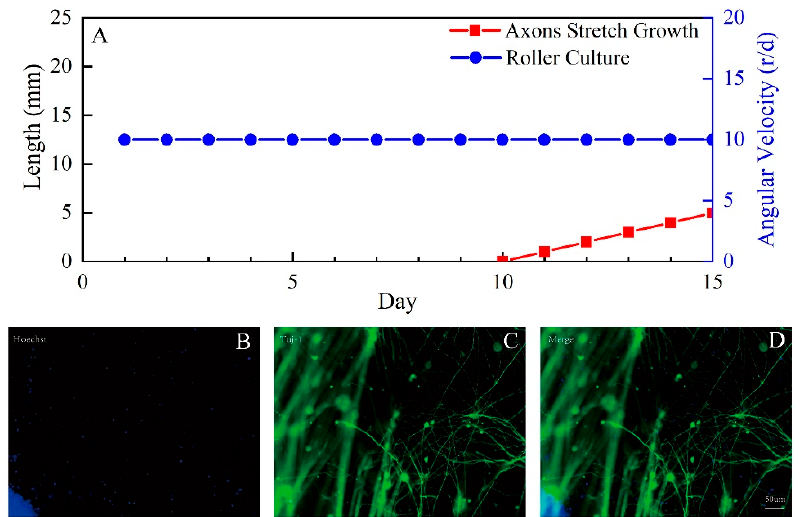
Figure 9. Immunofluorescence analysis of axons. ( A ) Flow Diagram of Experiment. ( B ) Antibodies against Hoechst (blue) showing the cell nucleus. ( C ) Antibodies against TuJ-1 (green) showing axons. ( D ) Merge. Scale bars: 50 μ m.